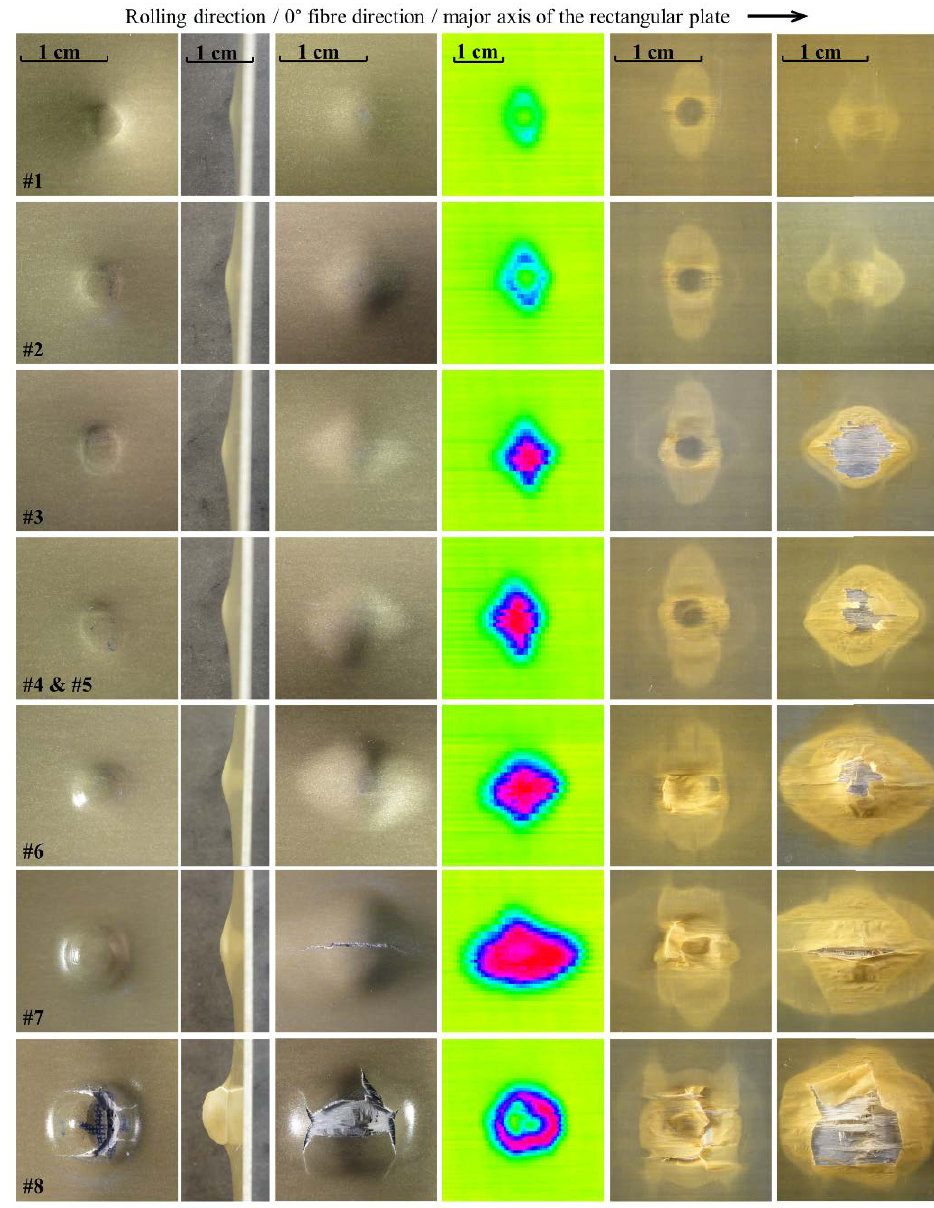
Figure 3. Views of front, lateral and back sides, C-scan, etched front and back sides of GLARE 5-2/1-0.3.